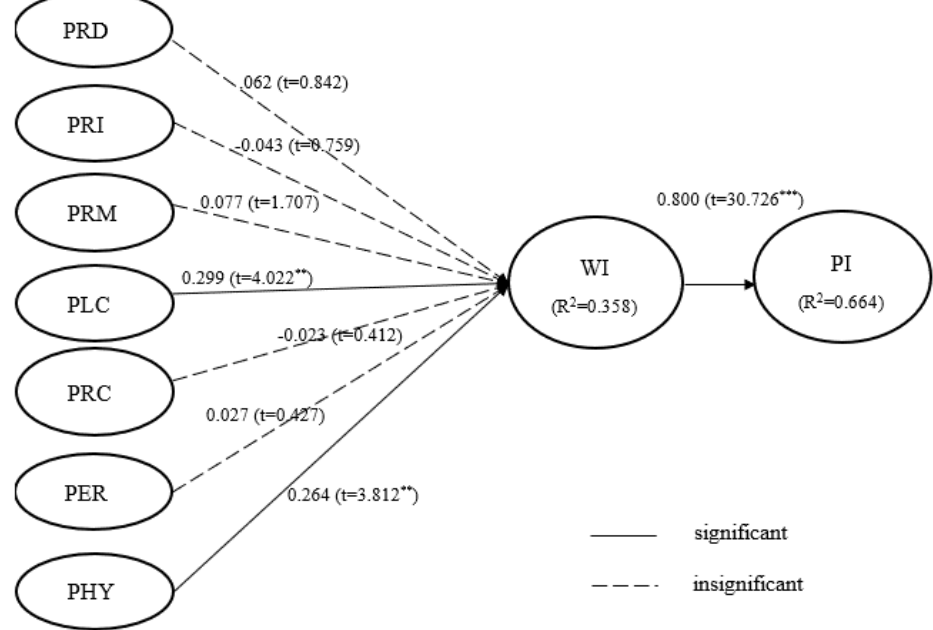
Figure 3. Hypothesis testing results for watching intention (Model 2). Note: Please refer to Appendix